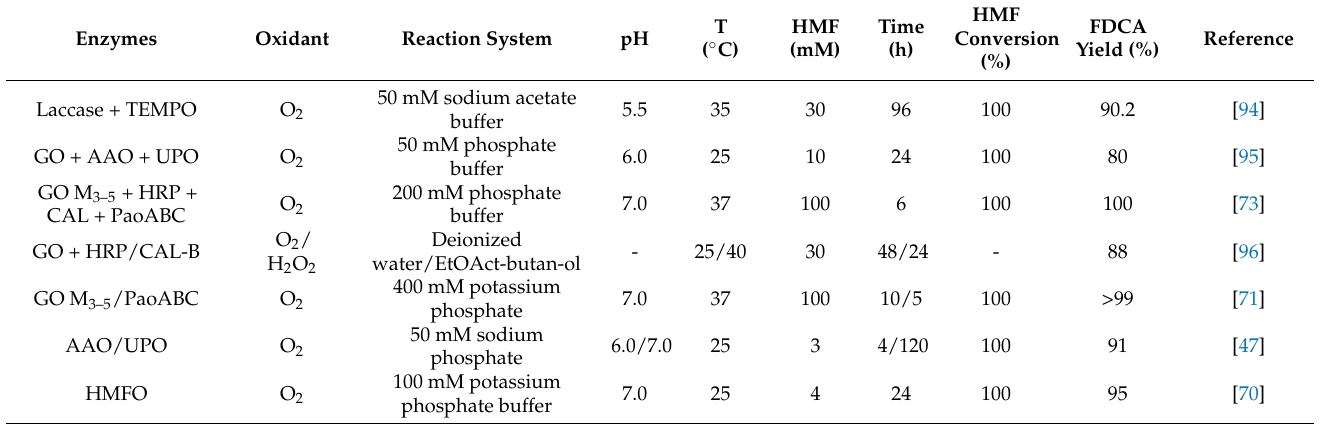
Table 2. Enzymatic oxidization of HMF into